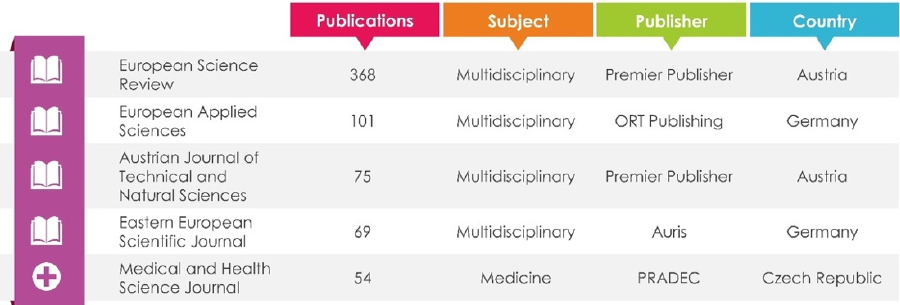
Figure 8. Top-five predatory journals based on the number of articles.